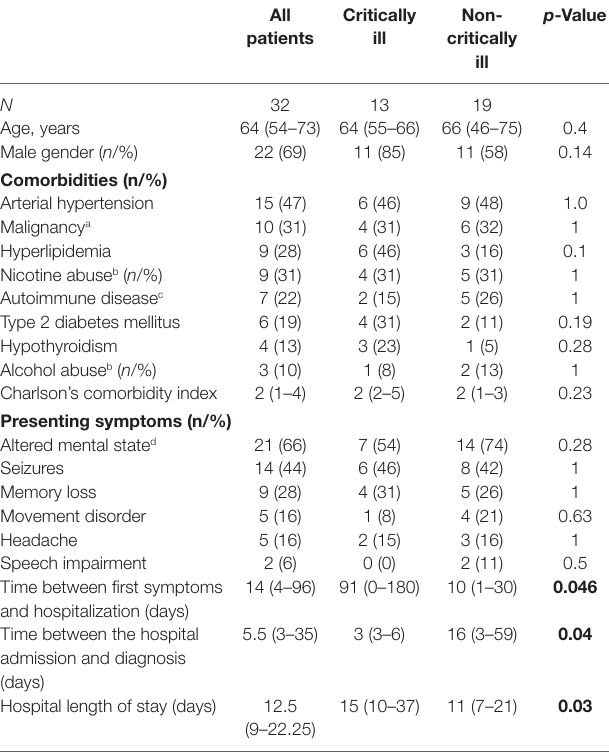
TaBle 1 | Clinical and demographic findings of 32 patients with autoimmune